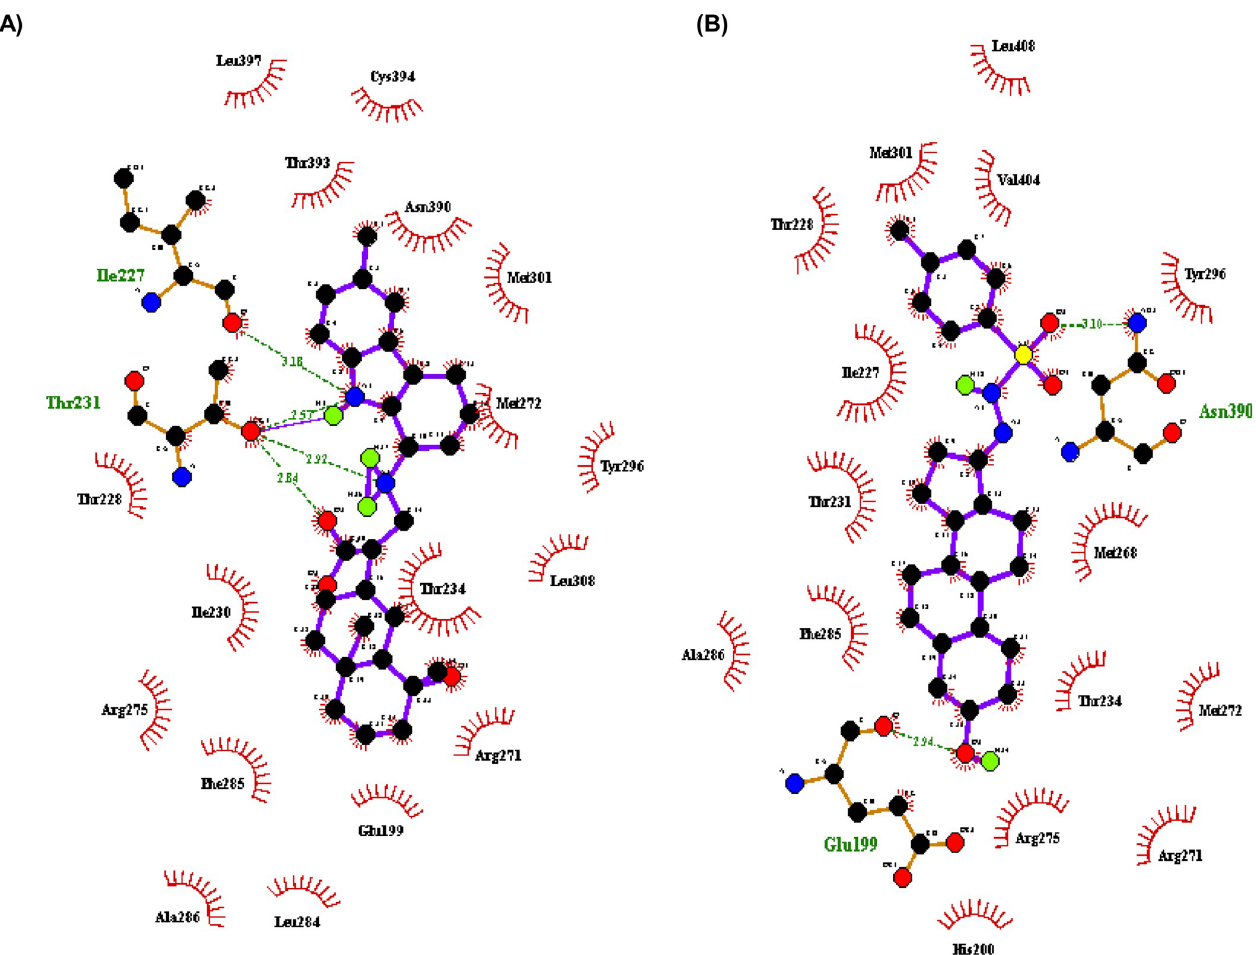
Fig 1. Protein-ligand interaction analysis. (A) BtEcR-ZINC08952607 docked complex structure generated through Ligplot showing hydrogen bonds with amino acid residues Thr231 and Ile227 as green lines and hydrophobic interactions as red arcs. (B) BtEcR-ZINC04264850 docked complex structure generated through Ligplot showing hydrogen bonds with amino acid residues Glu199 and Asn390 as green lines and hydrophobic interactions as red arcs.